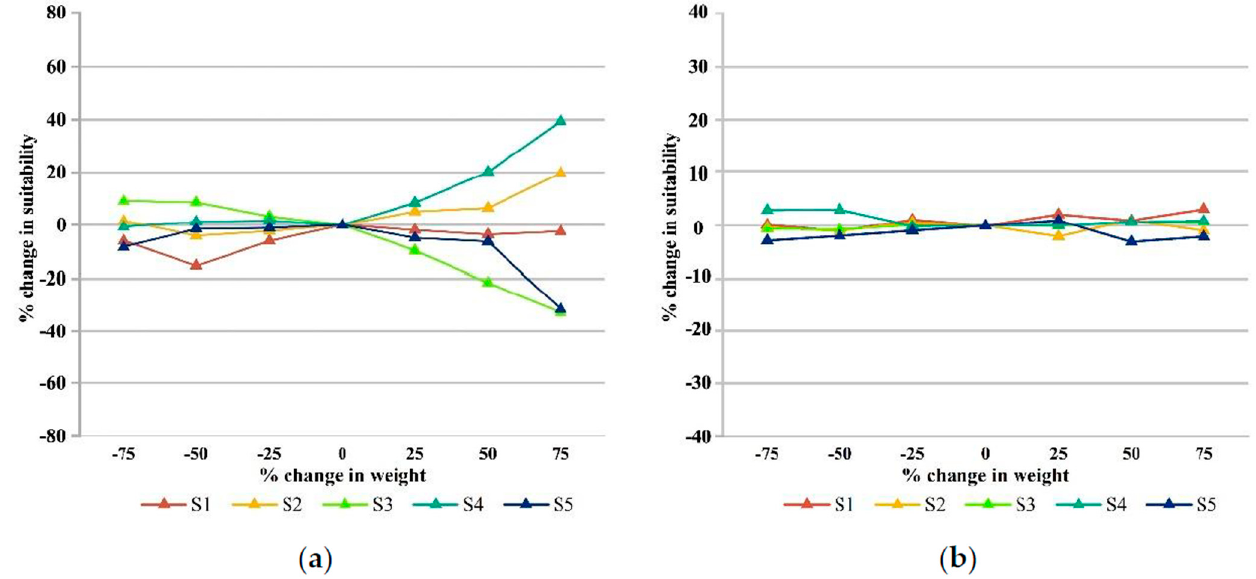
values of the other factors, resulting in more pronounced fluctuations in the highly suitable zone (Figure 7).